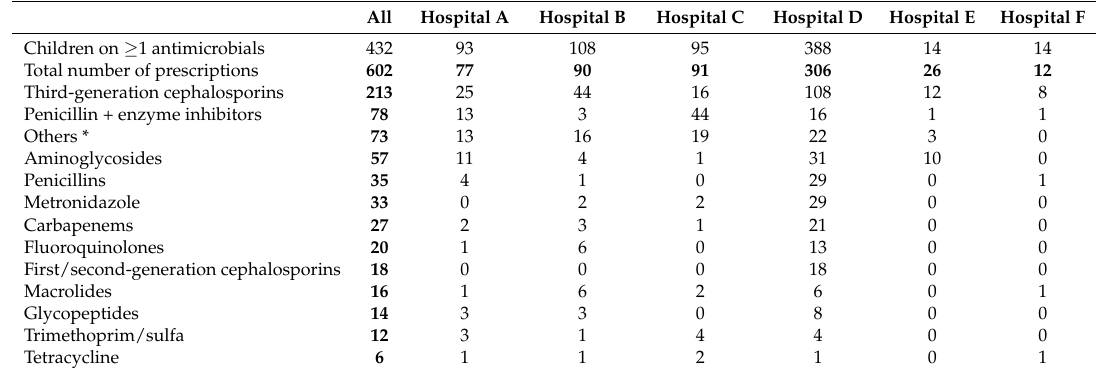
Table 3. Antimicrobial prescriptions for all indications among hospitalized children in six hospitals in India in 2016.